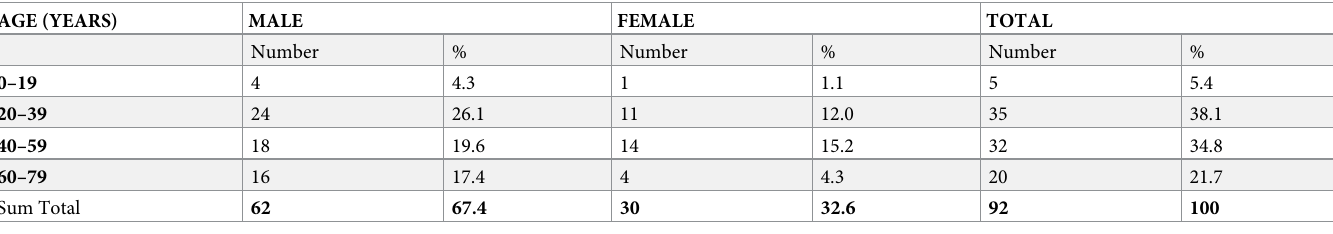
Table 1. Age and gender distribution of the colorectal cancer